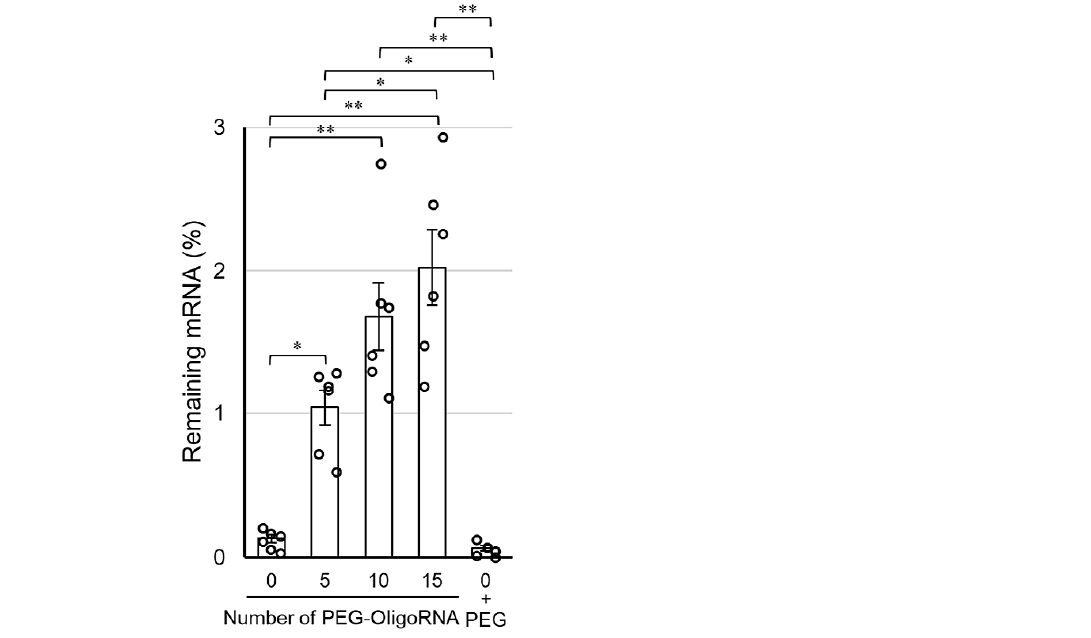
Figure 4. Remaining amount of mRNA after incubation in 1% FBS solution for 15 min. Data are shown as average mean ± SEM. Each dot refers to an individual measurement ( n = 6). Statistical difference was analyzed by ANOVA followed by Tukey’s test. Abbr., 0 + PEG: 0 *PEG-mRNA in the presence of free PEG strands. * p < 0.05, ** p < 0.01.